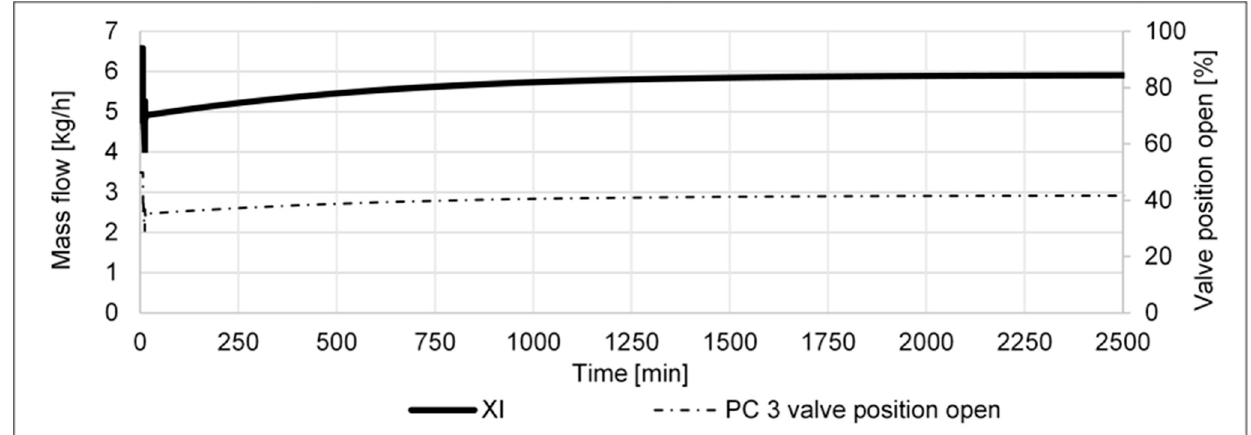
Figure 12 . Recycle mass fl ow and position of the recycle valve (left and right vertical axis) of scenario (e).